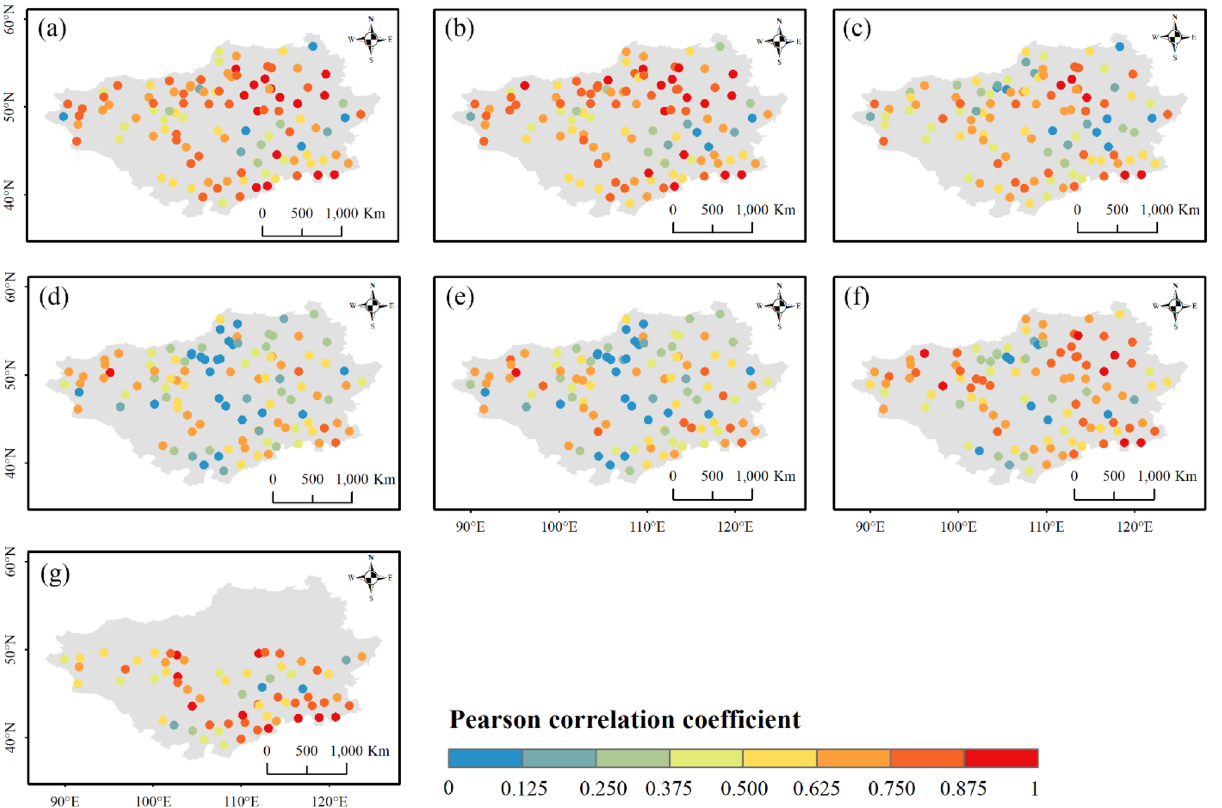
Figure 4. Pearson correlation coefficients between the precipitation decadal variability of stations and ( a ) ERA5-Land, ( b ) ERA5-HRES, ( c ) ERA-Interim, ( d ) IMERG ER, ( e ) IMERG LR, ( f ) IMERG FR, and ( g ) TMPA-3B42. For subplot ( g ), only stations within the spatial coverage of TMPA-3B42 (50° N–50° S) were plotted. The figure was created using ArcGIS 10.7 (https:// www. esri. com/ en- us/ arcgis/ about- arcgis/ overv iew) 70 .